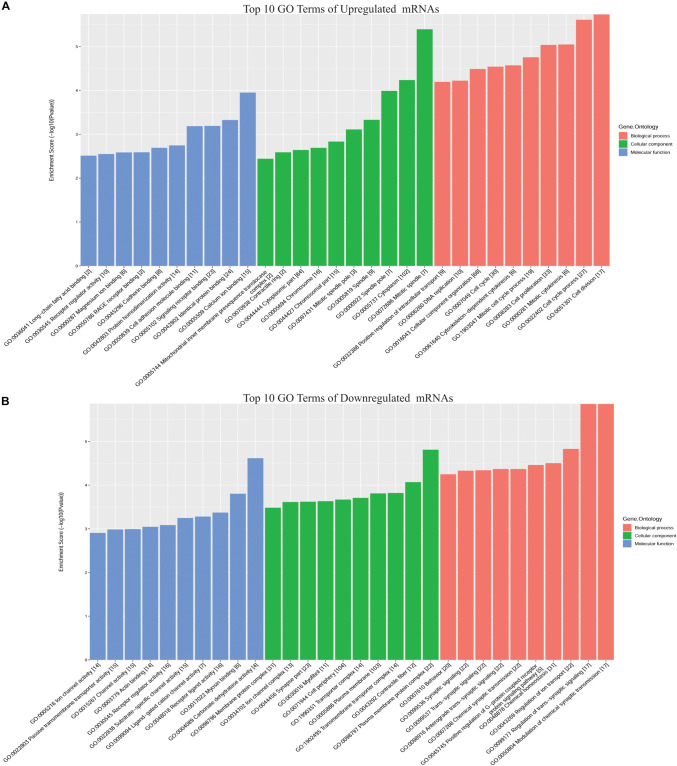
Top 10 GO terms for DE mRNAs in CRC. (A) Upregulated DE mRNAs; (B) downregulated DE mRNAs. GO annotation includes analyses in biological process (BP), cellular components (CC), and molecular function (MF).